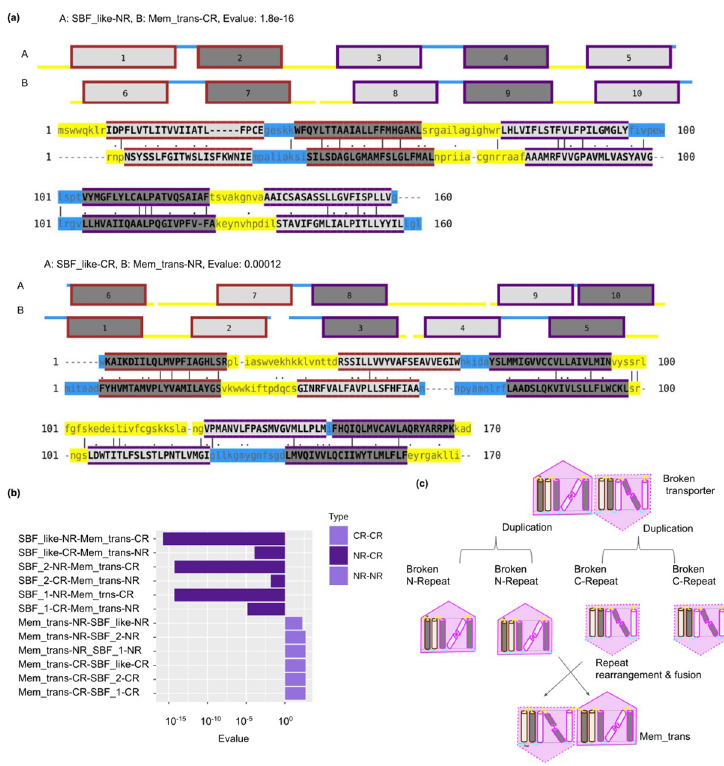
Fig 7. Change in orientation in broken transporters by shuffling. (a) Sequence and topology alignments, which shows the high similarity between N-terminal and C-terminal repeats of SBF_like and Mem_trans families and vice versa. All the transmembrane helices are numbered sequentially. (b) Sequence similarity, represented with E-values, between NR-NR, CR-CR and NR-CR repeats of two different families in the BART fold-type are shown. NR and CR refer to the N- and C-terminal repeats respectively. (c) Cartoon representation showing events of shuffling of repeats leading to change in orientation.